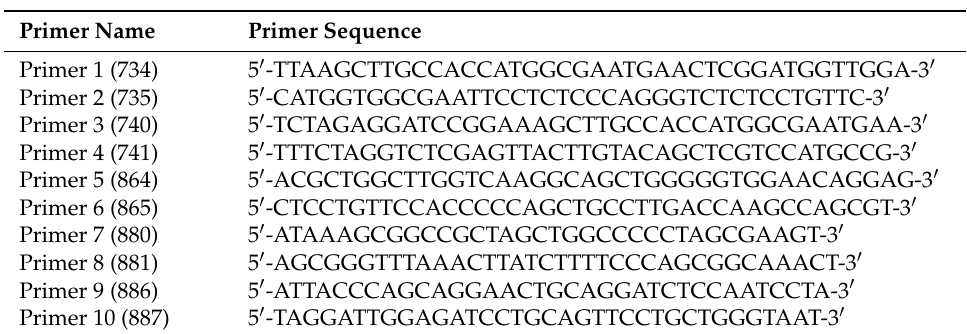
Table 1. Primers